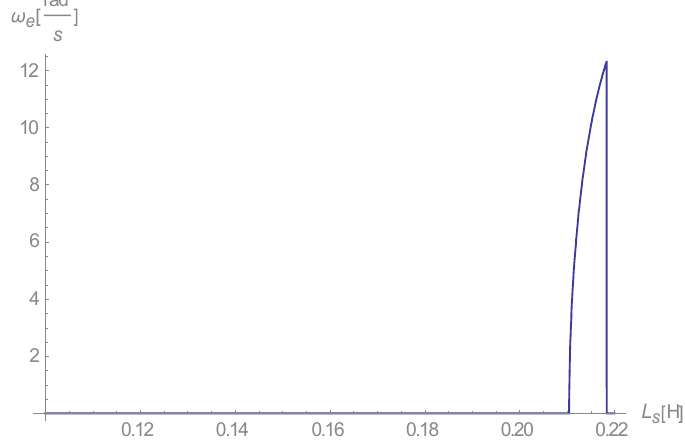
Figure 5. Plot of the imaginary part of the first solution of ω e (L S ).